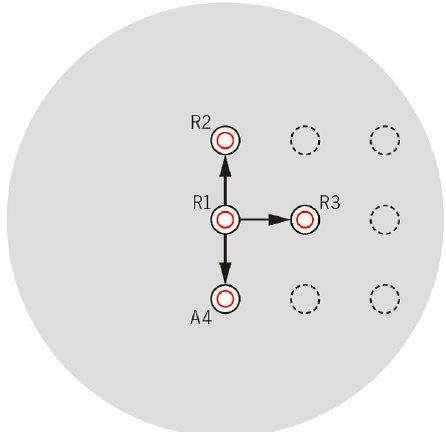
Fig. 8. A1 on R1 generated pheromone agents and accomplished to form a partial square by attracting A2, A3 and A4 with their robots R2, R3 and